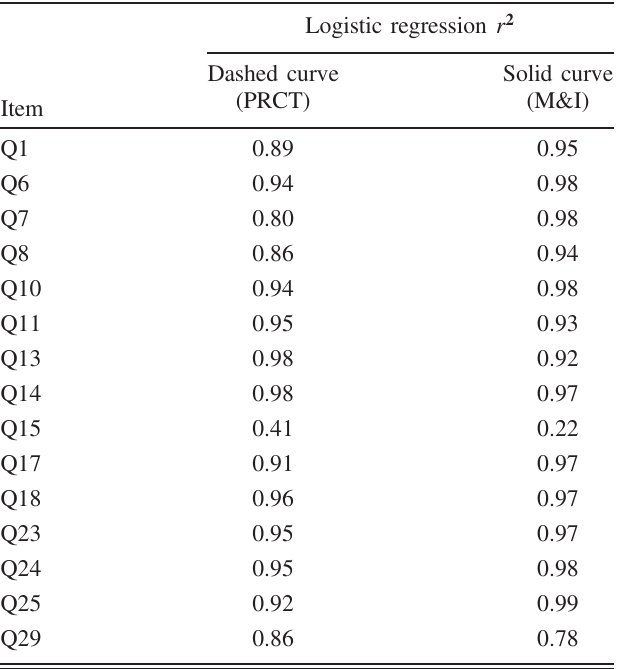
V. Coefficient of determination ( r 2 ) for logistic re- gression curves in Fig. 4. Dashed curves represent the PRCT course, and solid curves represent the M&I course. Note the regression curves are introduced solely for the purpose of visual representation and are not investigated for any particular model fit. Logistic regression r 2